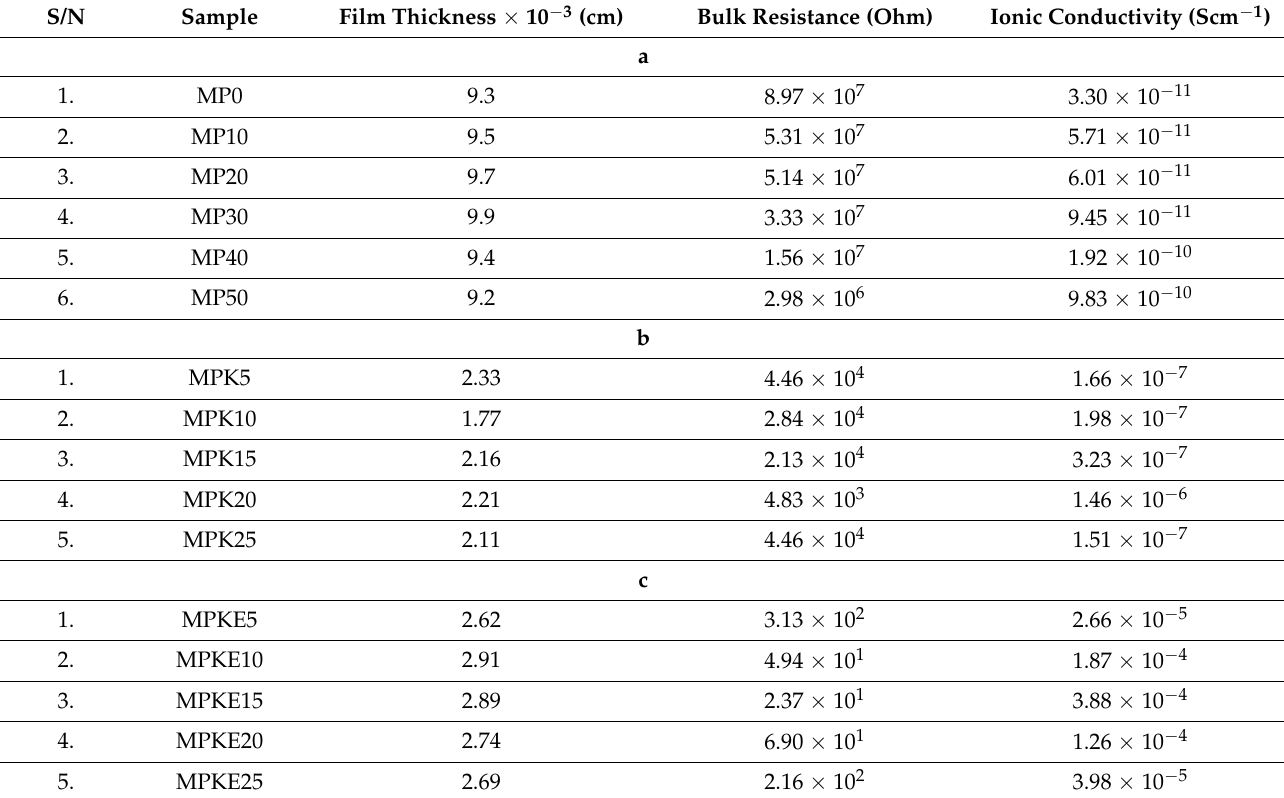
Table 1. (a) Ionic conductivity of MC/PVP polymer blend, (b) ionic conductivity of MC/PVP/K 2 CO 3 SPE, and (c) ionic conductivity of MC/PVP/K 2 CO 3 /EC